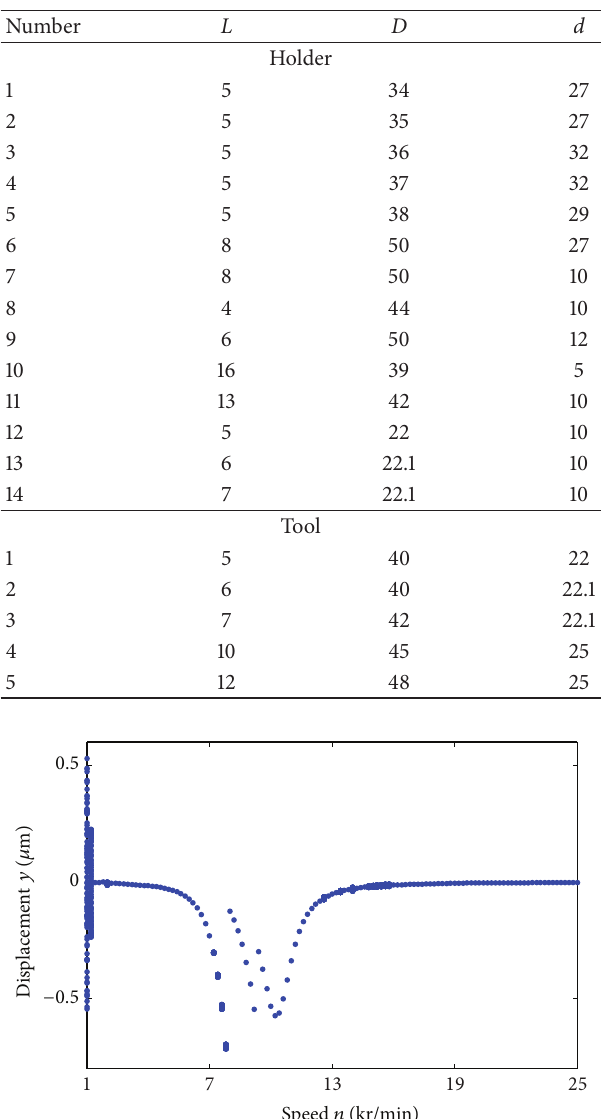
Figure 11: Global bifurcation of tool point in 𝑦 direction with different